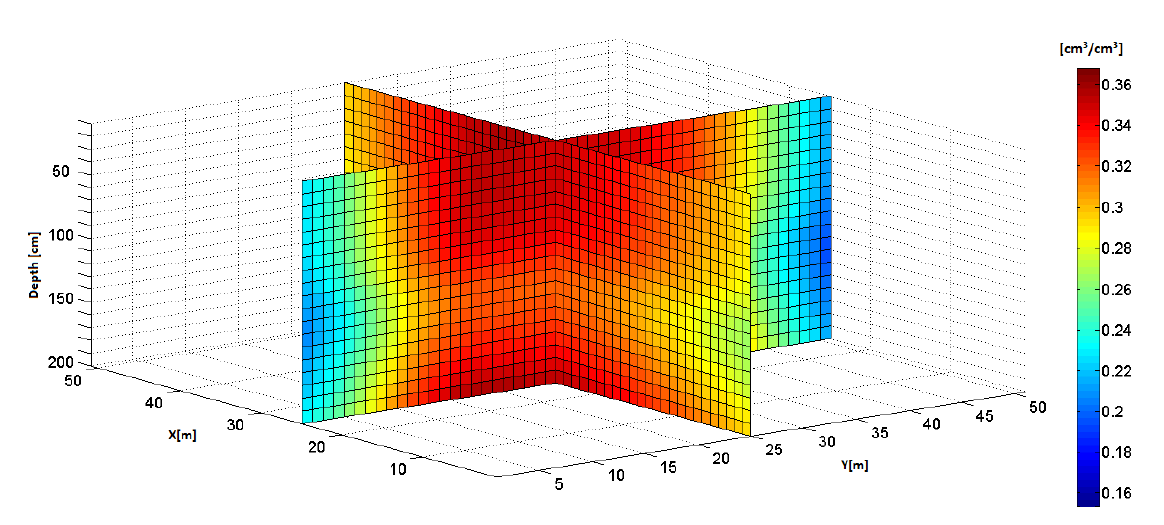
Figure 4. Water content section in clay soil textures.